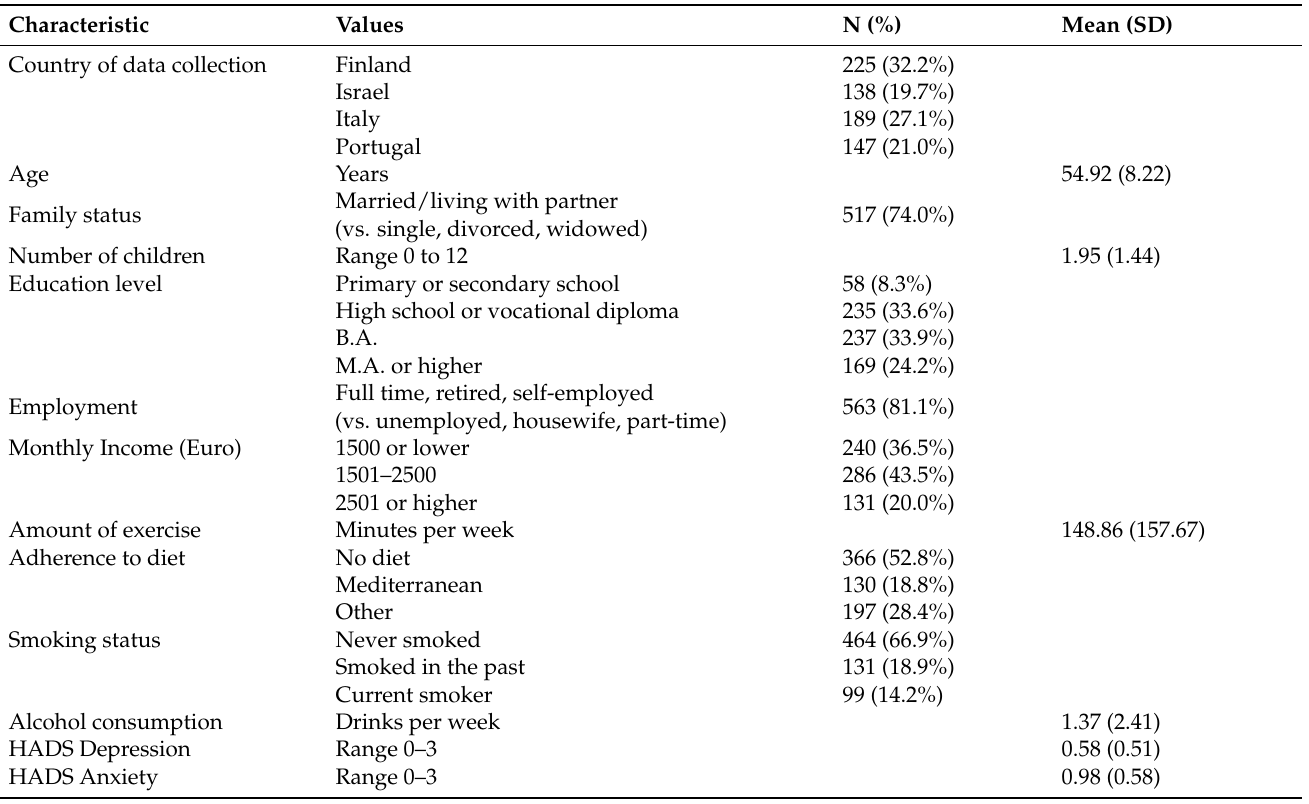
Table 1. Distribution of participant baseline sociodemographic and lifestyle characteristics (N =